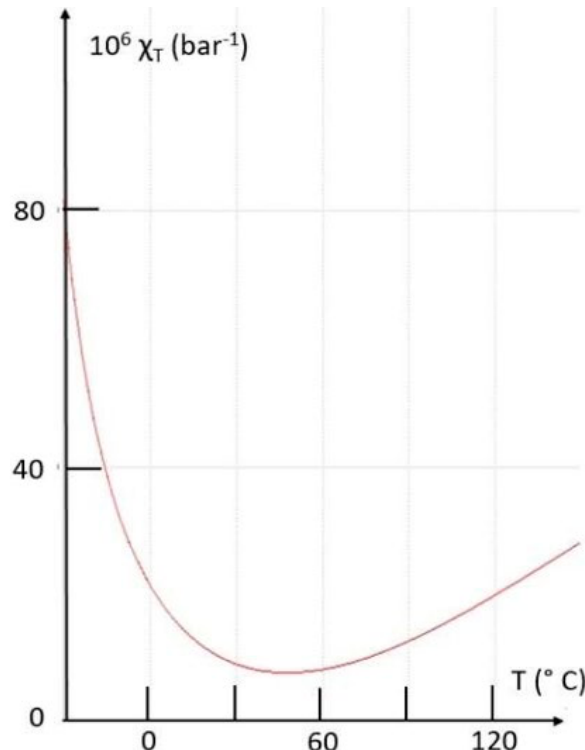
Figure 1. Isothermal compressibility of liquid water at atmospheric pressure. There is a minimum at 46